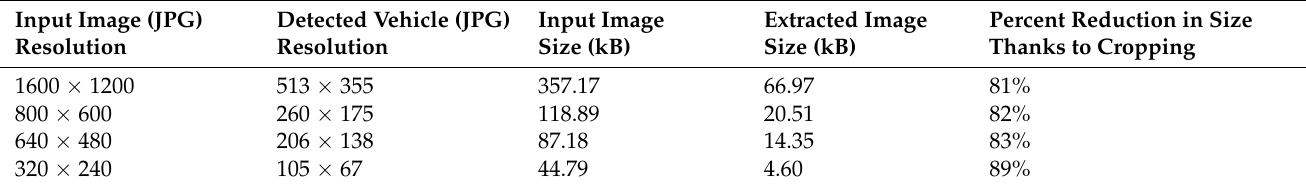
Figure 10. Output images from TINY-YOLOv3 algorithm: ( a ) detected vehicle and ( b ) cropped- out vehicle. Table 2. Images with their input/output properties (resolution, size in kB) and percent reduction in size when processed in JPG format before and after the application of